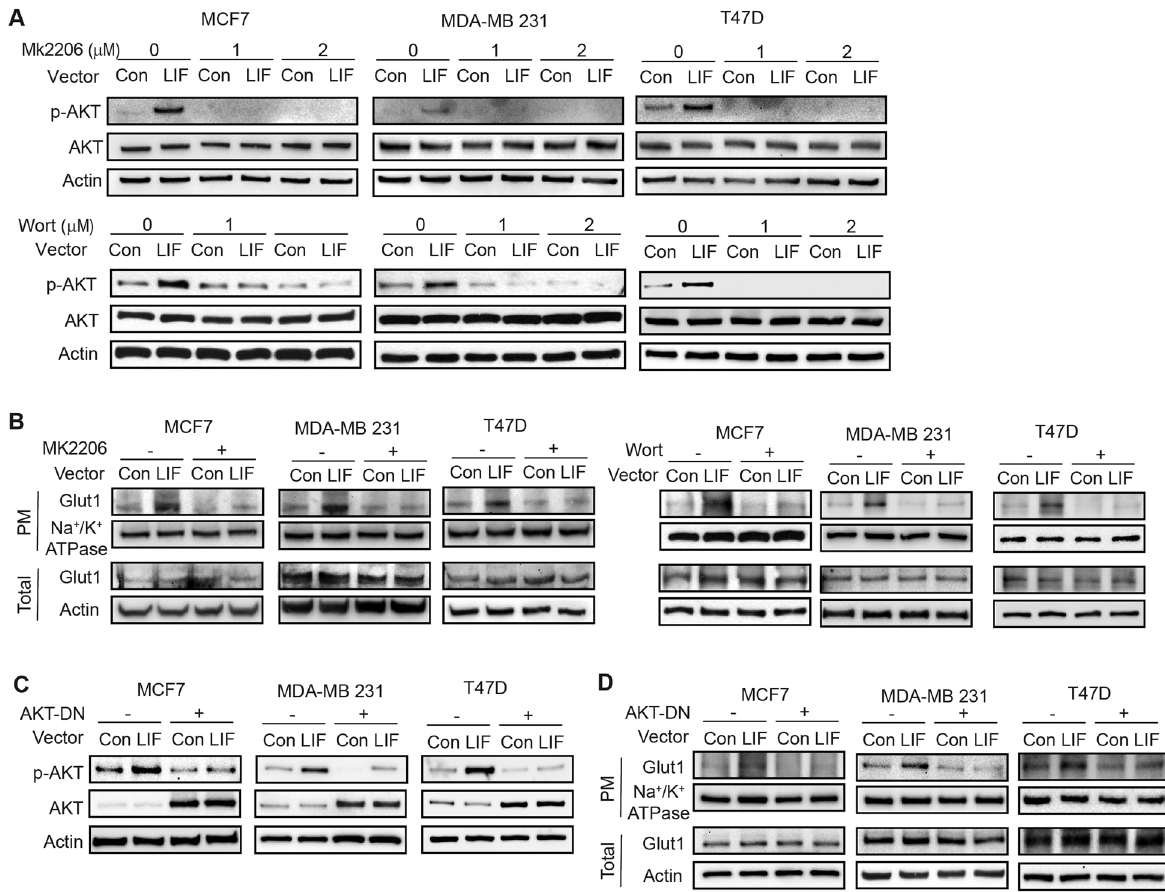
Fig. 6 LIF promotes Glut1 PM translocation through the activation of AKT signaling. A LIF activated the AKT signaling, which can be blocked by MK2206, an AKT inhibitor (upper panel), or Wortmannin (Wort), a PI3K inhibitor (lower panel), in MCF7, MDA-MB 231 and T47D cells. The levels of p-AKT Ser473 (p-AKT), which re fl ect the activity of AKT were measured by Western-blot assays. B Blocking AKT signaling by MK2206 (left) or Wortmannin (right) largely abolished the promoting effect of LIF on Glut1 PM translocation in breast cancer cells. C , D Blocking AKT signaling by expression of dominant-negative AKT (AKT-DN) largely abolished the promoting effect of LIF on Glut1 PM translocation in breast cancer cells. Cells were transfected with vectors expressing AKT-DN. The levels of p-AKT and total AKT ( C ), as well as Glut1 PM translocation ( D ), were determined by Western-blot assays. Uncropped Western-blot images are shown in Supplementary Fig